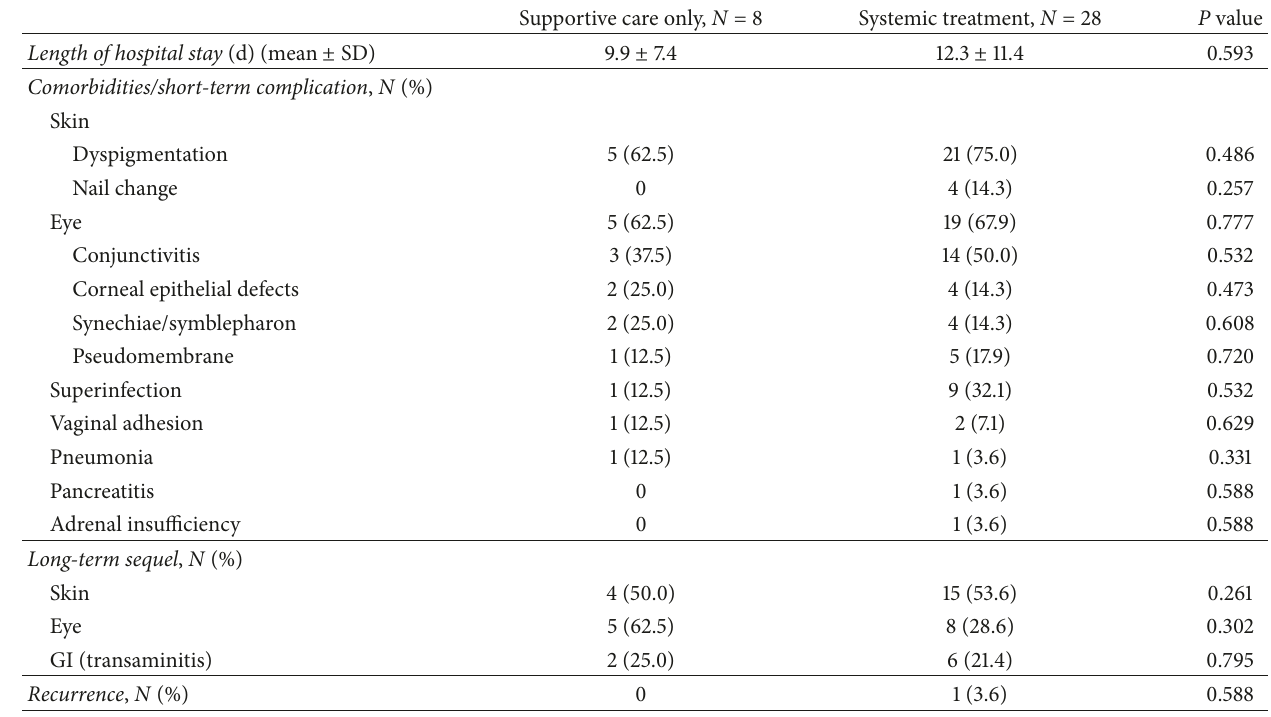
Table 5: Treatment outcomes according to supportive care alone versus systemic treatment. Supportive care only, N =